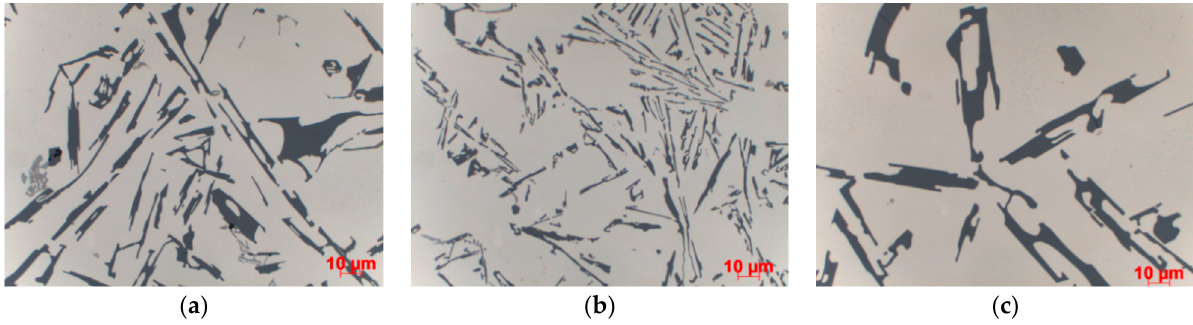
Figure 8. Morphology of eutectic silicon in casting made in Sand No. 4, centre, LM, etched with HF, 1000× magnification; ( a ) die, ( b ) ablation, ( c ) sand mould.